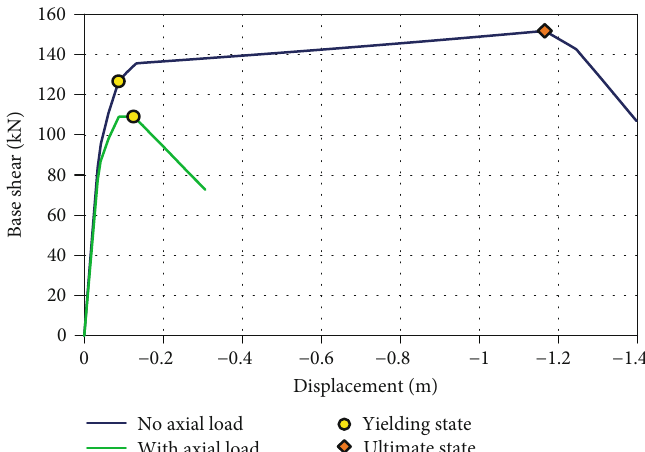
Figure 10: Base shear versus pile cap displacement (lateral spreading as fl ow pressure).